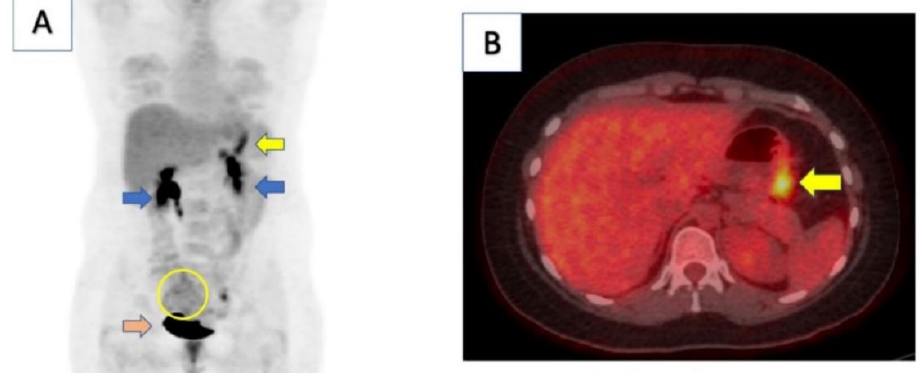
Figure 1. Computed tomography (CT)/positron emission tomography (PET) scan of patient demon- strated moderate focal uptake along gastric body consistent with known malignancy (yellow arrow in panel ( A , B )). There was also a large, mildly hypermetabolic right adnexal area with heterogenous uptake, indicating metastatic involvement (yellow circle). Kidneys (blue arrows) and bladder (orange arrow) demonstrate physiologic uptake. Reproduced from